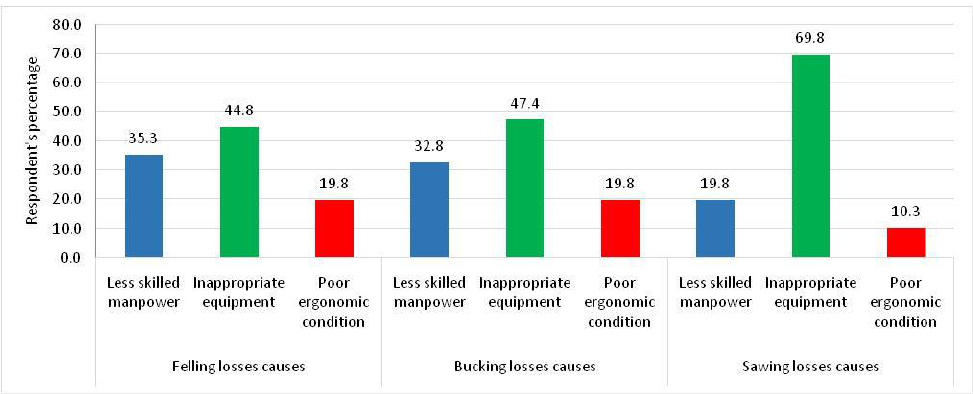
Figure 5. Bar graph showing causes of losses in different stages of the timber harvesting process.